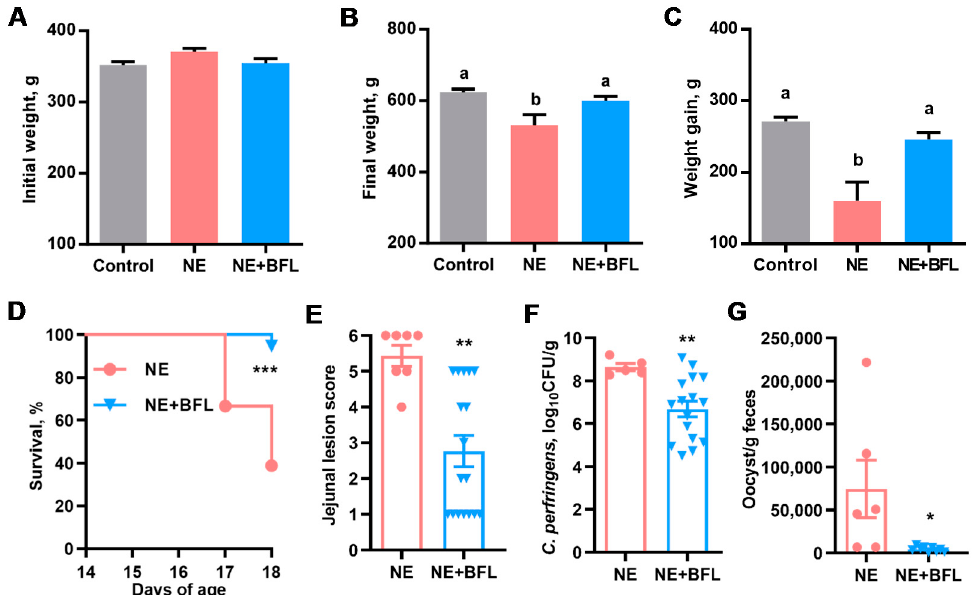
Figure 4. Alleviation of necrotic enteritis (NE) in broiler chickens by supplementation of butyrate, forskolin, and lactose. Day-old male Cobb chicks were supplemented with or without a mixture of 1 g/kg microencapsulated sodium butyrate, 10 mg/kg forskolin-containing C. forskohlii extract, and 10 g/kg lactose (NE + BFL) ( n = 18) upon arrival. Chickens in the NE or NE + BFL group were orally challenged with 1 × 10 4 E. maxima oocysts on day 11, followed by daily challenges with approximately 2 × 10 9 CFU C. perfringens from days 14–16, while the animals in the Control group were mock-infected. Chickens were weighed individually on day 14 ( A ) and day 18 ( B ), and weight gain from days 14 to 18 ( C ) was calculated. Weight and weight gain were analyzed with ANOVA and post hoc Tukey’s test. Means with different letters are significantly different ( p < 0.05). Animal survival from days 14–18 ( D ) was recorded daily and compared using the logrank test. On day 18, jejunal lesion score ( E ), jejunal C. perfringens titer ( F ), and oocyst shedding in the feces ( G ) were evaluated and subjected to unpaired Student’s t -test. Results are presented as means ± SEM. * p < 0.05, ** p < 0.01, and *** p < 0.001.